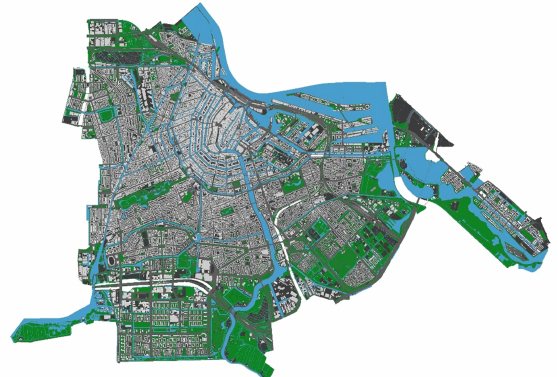
Figure 7. CityGML model of Amsterdam in LoD 1.